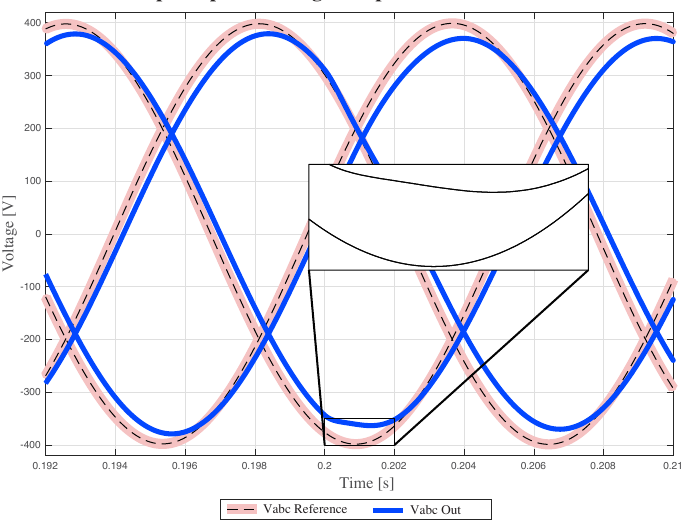
Figure 9. Comparing reference signal vs. output voltages with proposed strategy classical PID controller. The optimization algorithm’s outcomes for the primary loop are displayed in